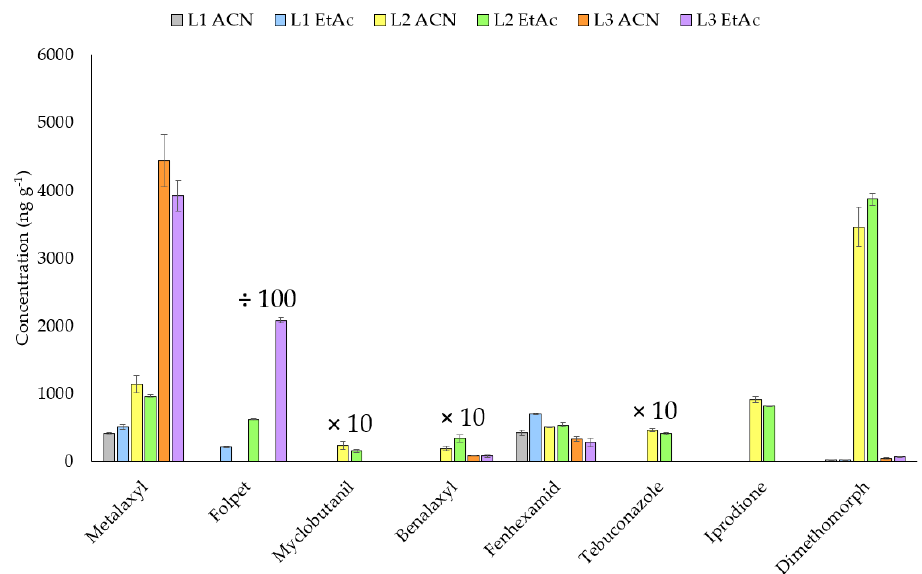
Figure 3. Comparison of ACN and EtAc in vine leaves which contain fungicides. ÷ 100: concentration of folpet divided by 100; × 10: concentration of myclobutanil, benalaxyl and tebuconazole multiplied by 10.